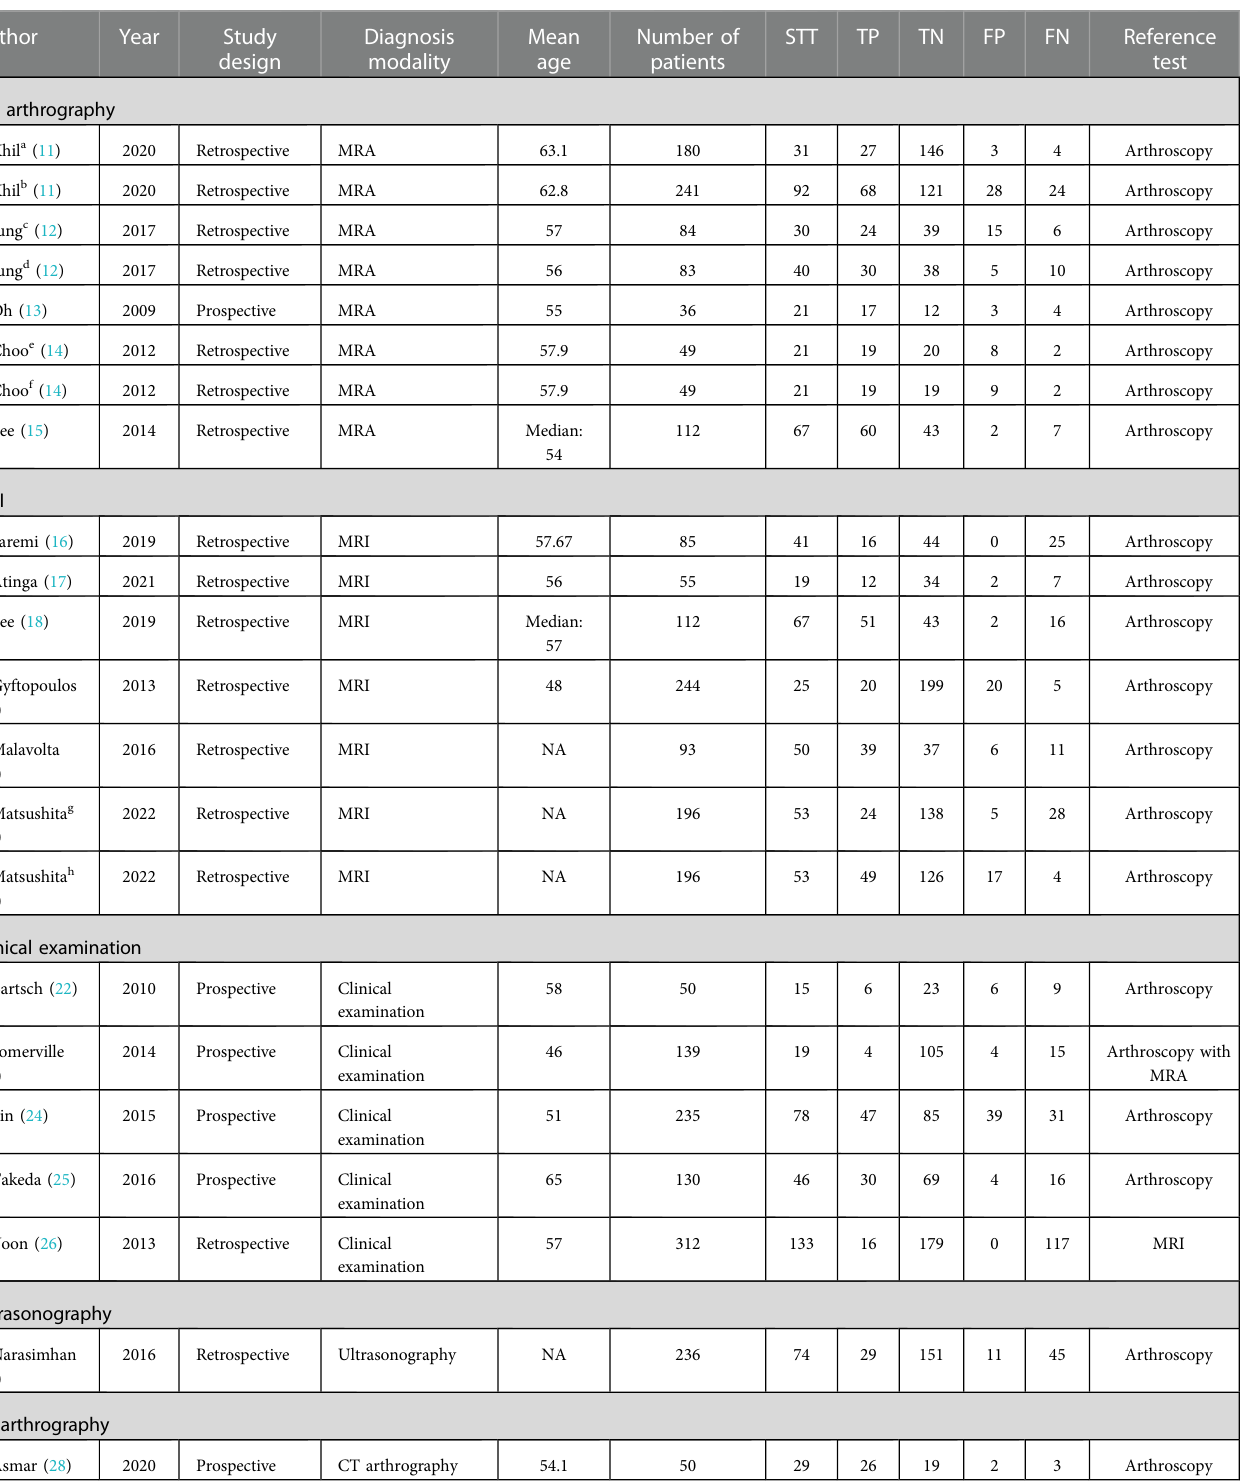
TABLE 1 Characteristics of included